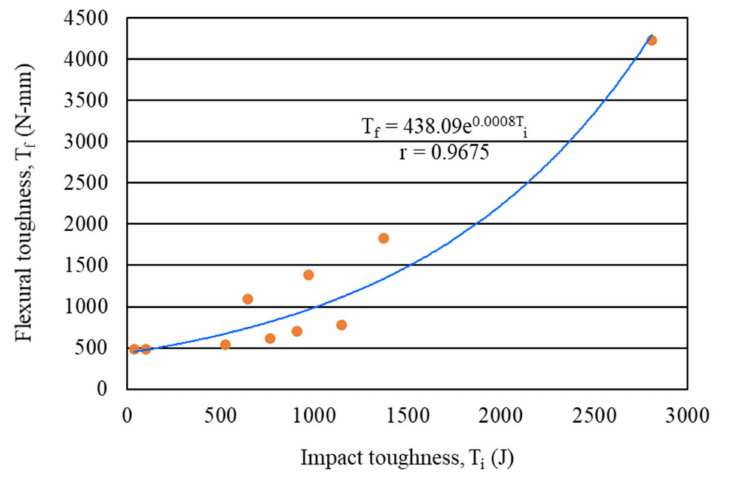
Figure 15. Correlation between the flexural and impact toughness of mortar